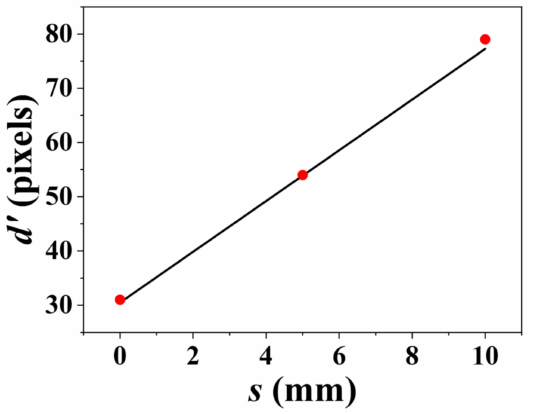
Figure 11. Variation in d’ with s .